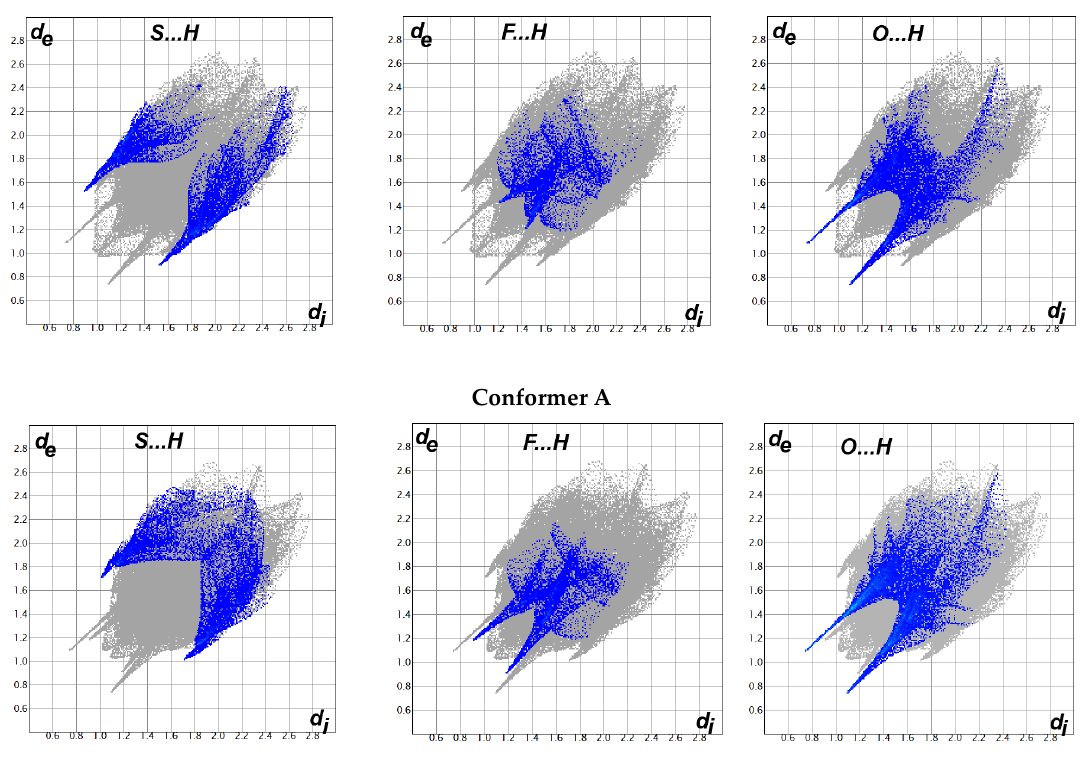
Figure 7. The decomposed fingerprint plots of the most important intermolecular contacts in the crystal structure of the studied